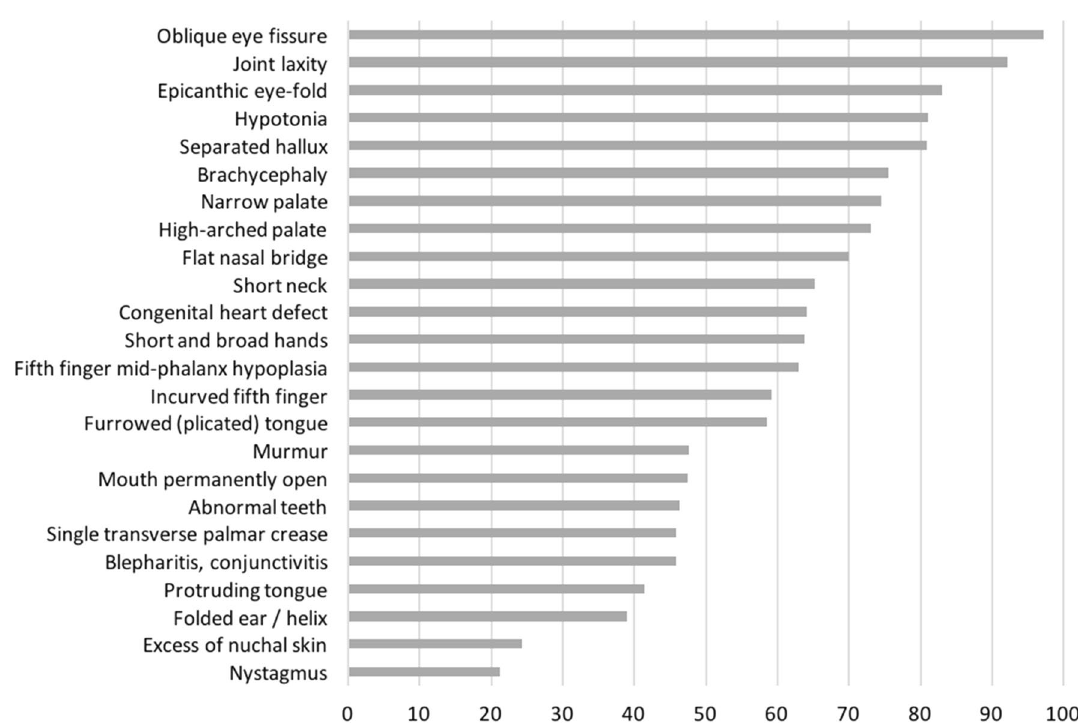
Figure 1. Representation of frequencies of Jackson’s signs in our study sample. Brushfield spots was excluded. Details on frequency and number of subjects with available information and with the sign present are in Table